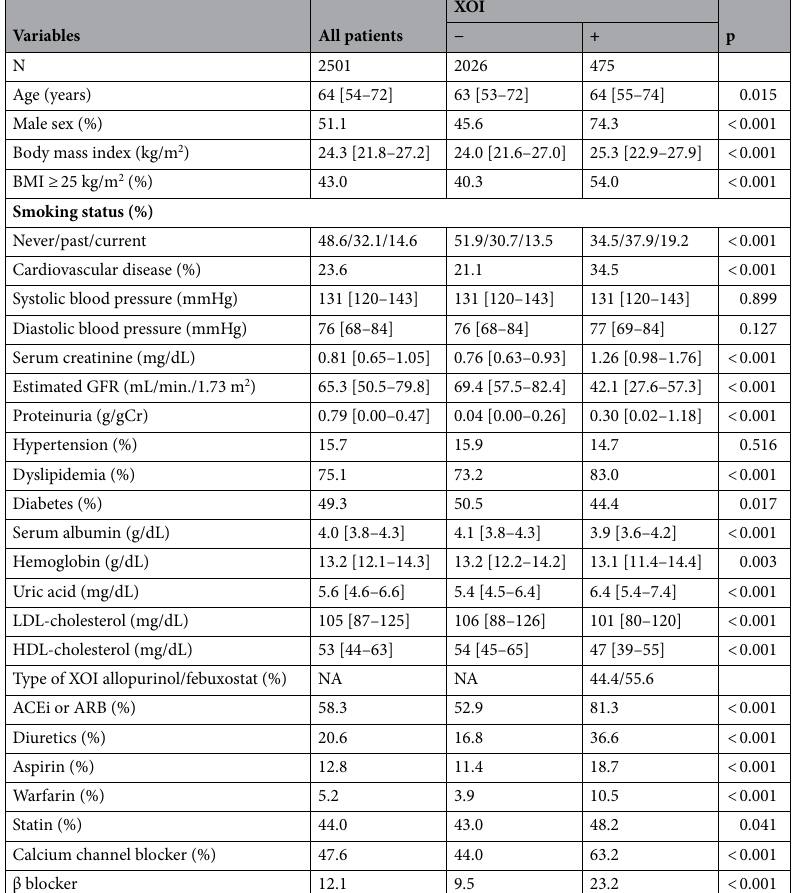
Table 1. Characteristics of the study patients at baseline. Categorical variables are expressed as percentages and continuous variables as median [interquartile range]. XOI xanthine oxidase inhibitor, BMI body mass